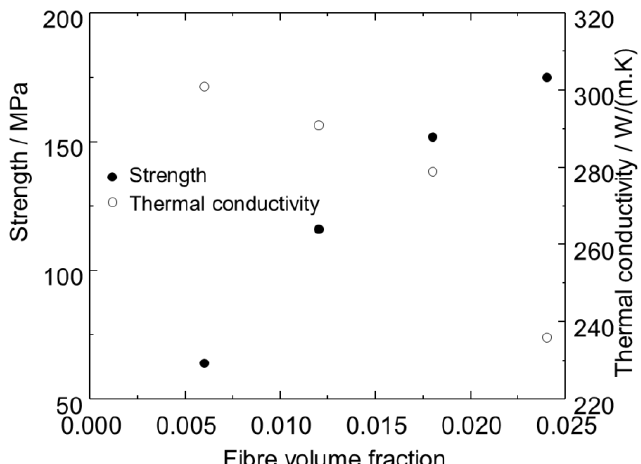
Figure 10. Strength and thermal conductivity of aluminium matrix composites containing 48% of graphite flakes versus the carbon fibre volume fraction. Experimental data published in [34].